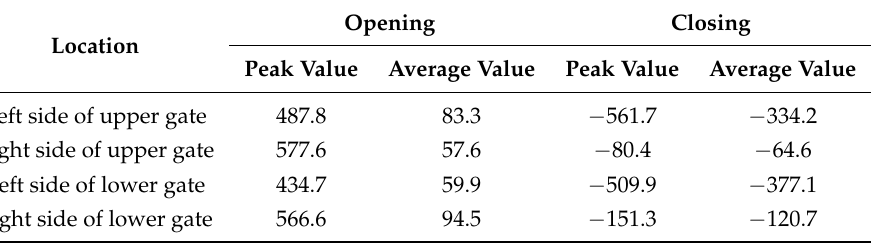
Table 3. Operating loads of the hydrostatic test (unit: kN).